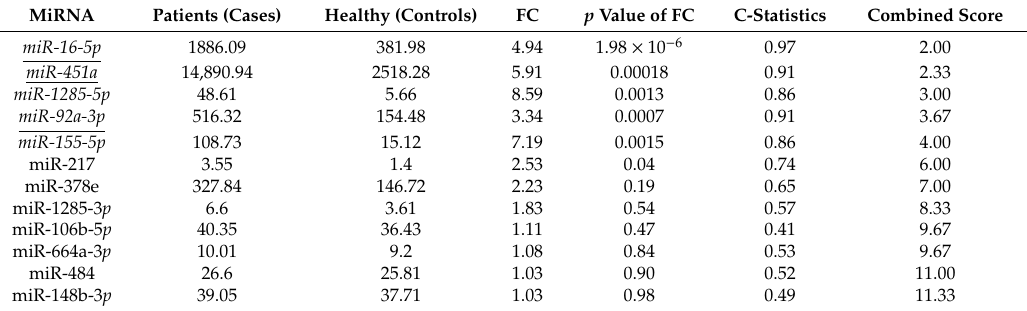
Table 2. Detected levels of the 12 miRNAs identified from the three signatures (discovery set), ranked by a combined score, which includes the averages of the ranked fold change (largest to smallest), p value (smallest to largest), and C-Statistics (largest to smallest). The lower the combined score, the more